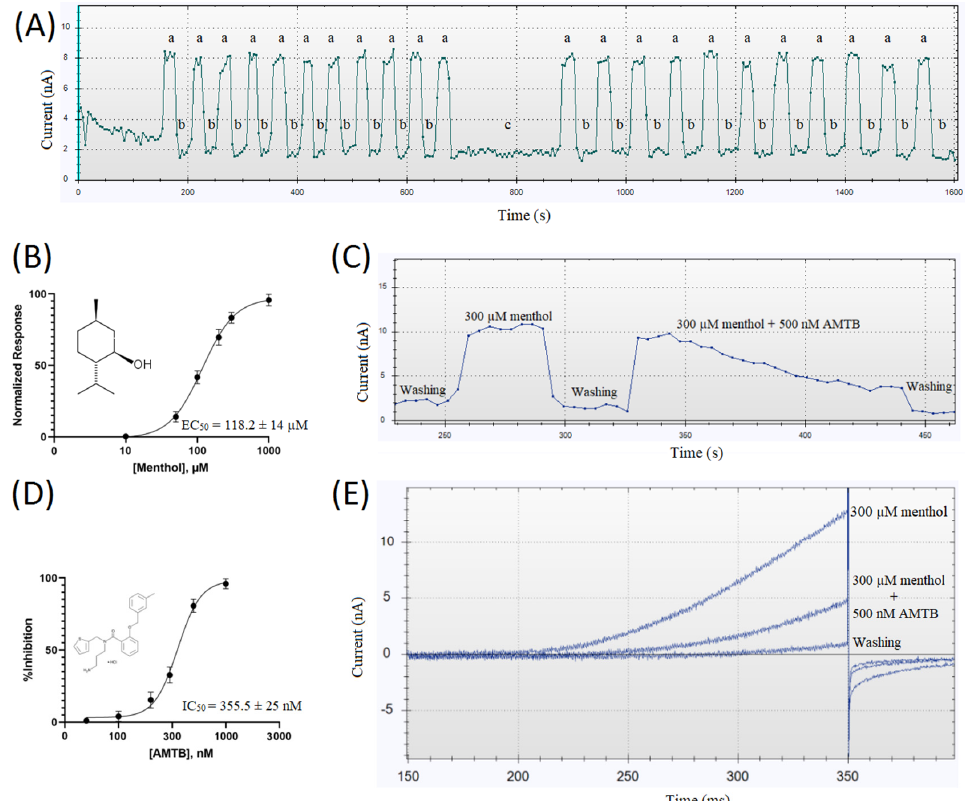
Figure 1. ( A ) Recorded outward currents at +80 mV from HEK-293 cells stably expressing TRPM8 were obtained using the Ionflux 16 device. Currents were evoked by a voltage ramp from − 100 to +100 mV, in the presence of 300 µ M menthol (a) or 0.3% DMSO (vehicle) (b), and then (c) washed with 0.3% DMSO for a longer period (200 s). Note that menthol evokes a reproducible and time- independent current. ( B ) Dose response curve for menthol with an EC 50 = 118.2 ± 14 µ M. ( C ) Outward currents recorded at +80 mV from HEK-293 cells stably expressing TRPM8, during washing with an external solution containing the vehicle followed by perfusion with 300 µ M menthol alone or in combination with 500 nM AMTB. ( D ) Dose response curve for AMTB with an IC 50 = 355.5 ± 25 nM; IC 50 and EC 50 were calculated by fitting the four-parameter Hill equation. All data are shown as the mean ± SD ( n ≥ 6). ( E ) Outward currents elicited in HEK-293 cells stably expressing TRPM8 by 300 containing the vehicle, using a voltage ramp protocol from − 100 to +100 mV over 200 ms. Table 1. TRPM8 percent inhibition